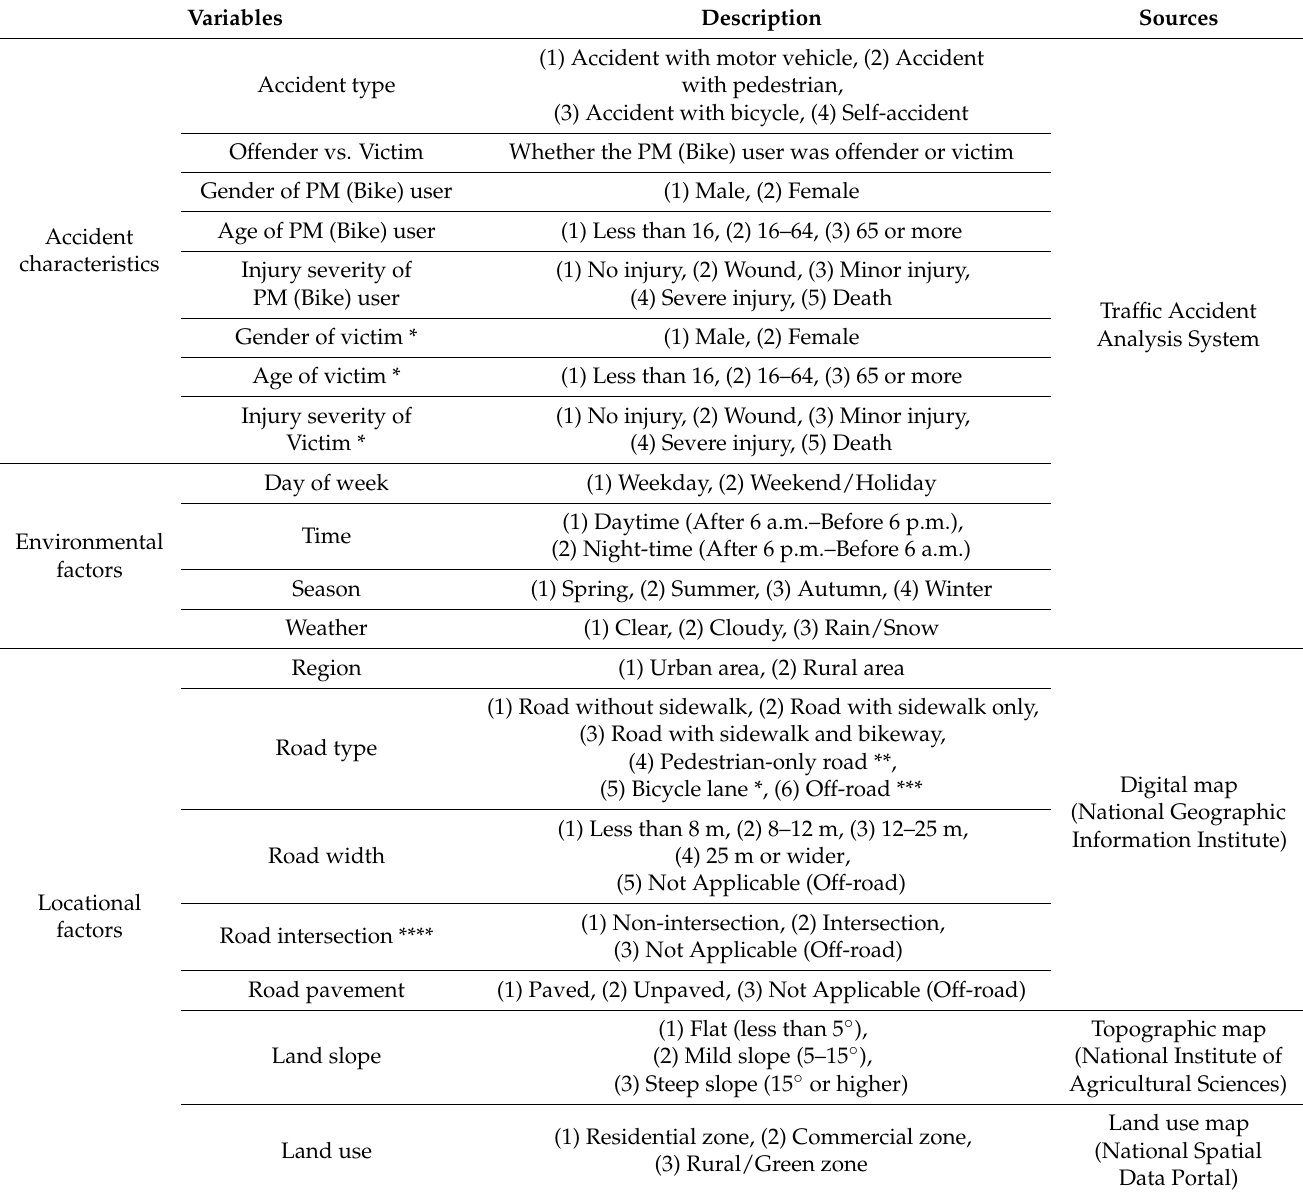
Table 1. Description of variables used in the